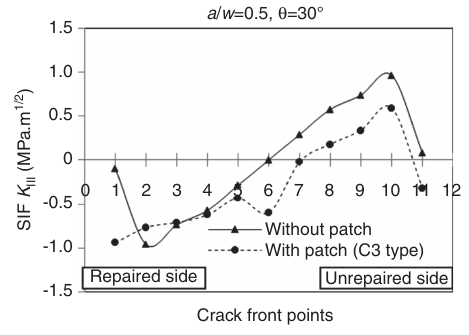
Figure 23 Effect of patch on K